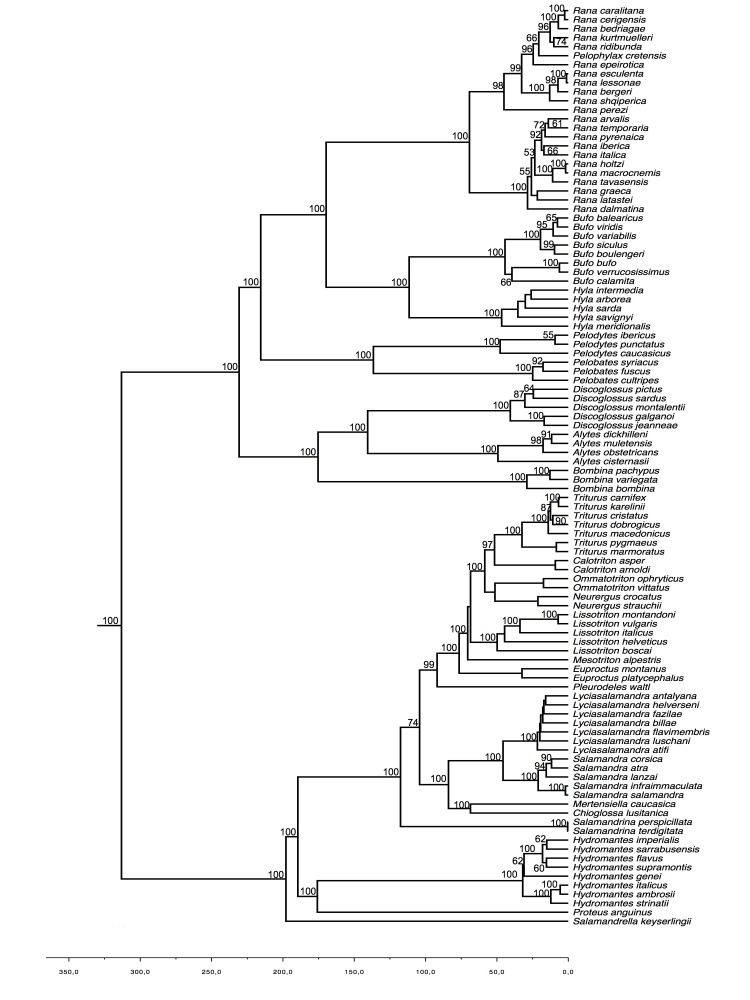
Phylogenetic tree obtained by maximum likelihood inference with
RaxML (outgroups have been removed). Numbers above branches
indicate bootstrap values.